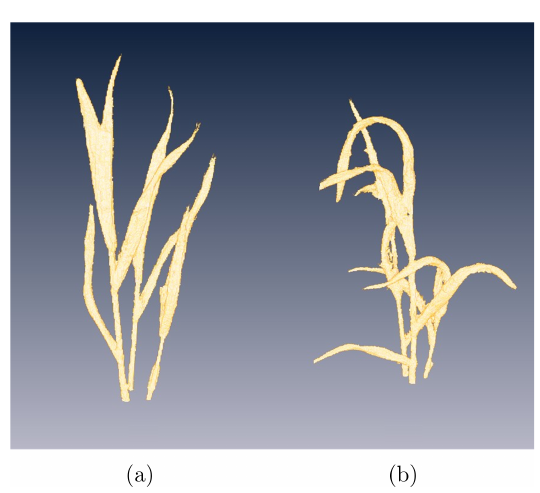
Fig. 7. Volumetric models of plants, with a voxel size of 1 mm.